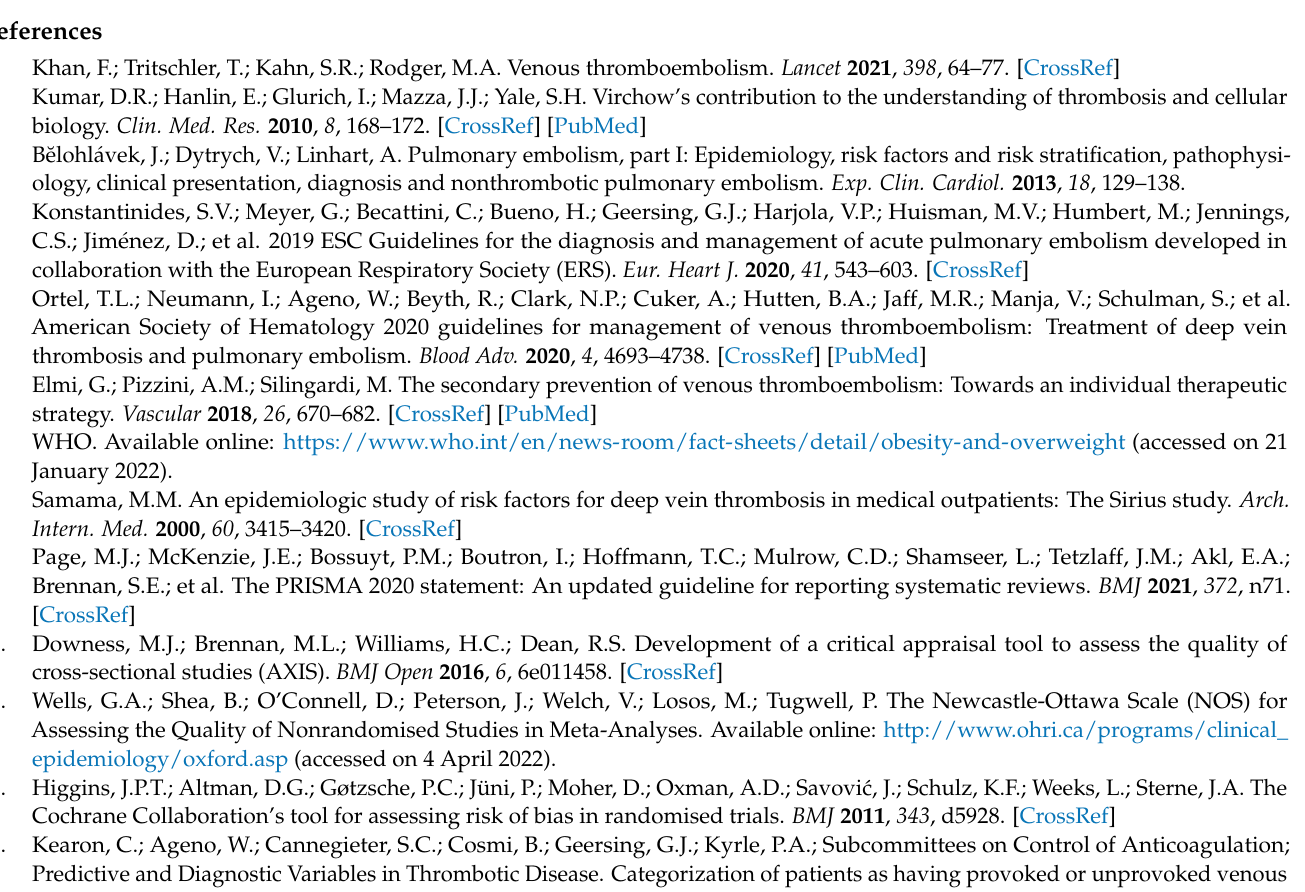
Table S2: The Newcastle-Ottawa scale for quality assessment of cohort and case controls studies; Table S3: Risk of bias of randomized controlled trials included in the analysis performed with the Cochrane collaboration risk of bias tool (CCRBT) for the randomized controlled trial; Table S4: Quality assessment of cross-sectional studies performed with AXIS